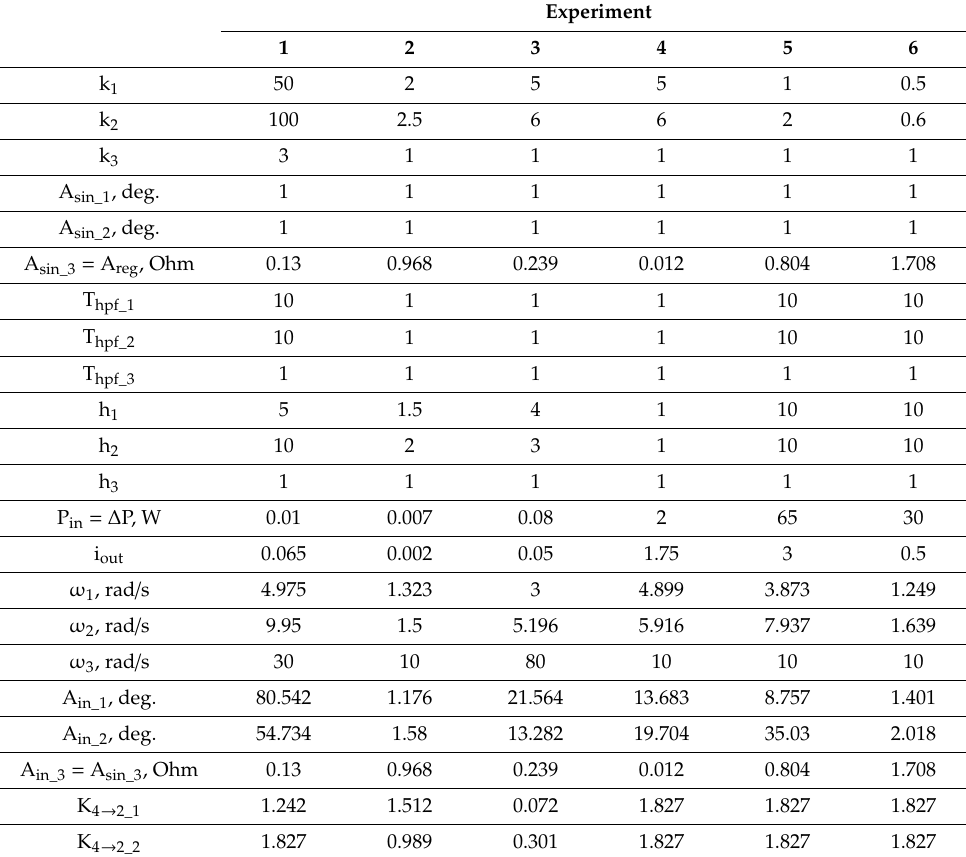
Table 8. Parameters and settings of extremum seeking